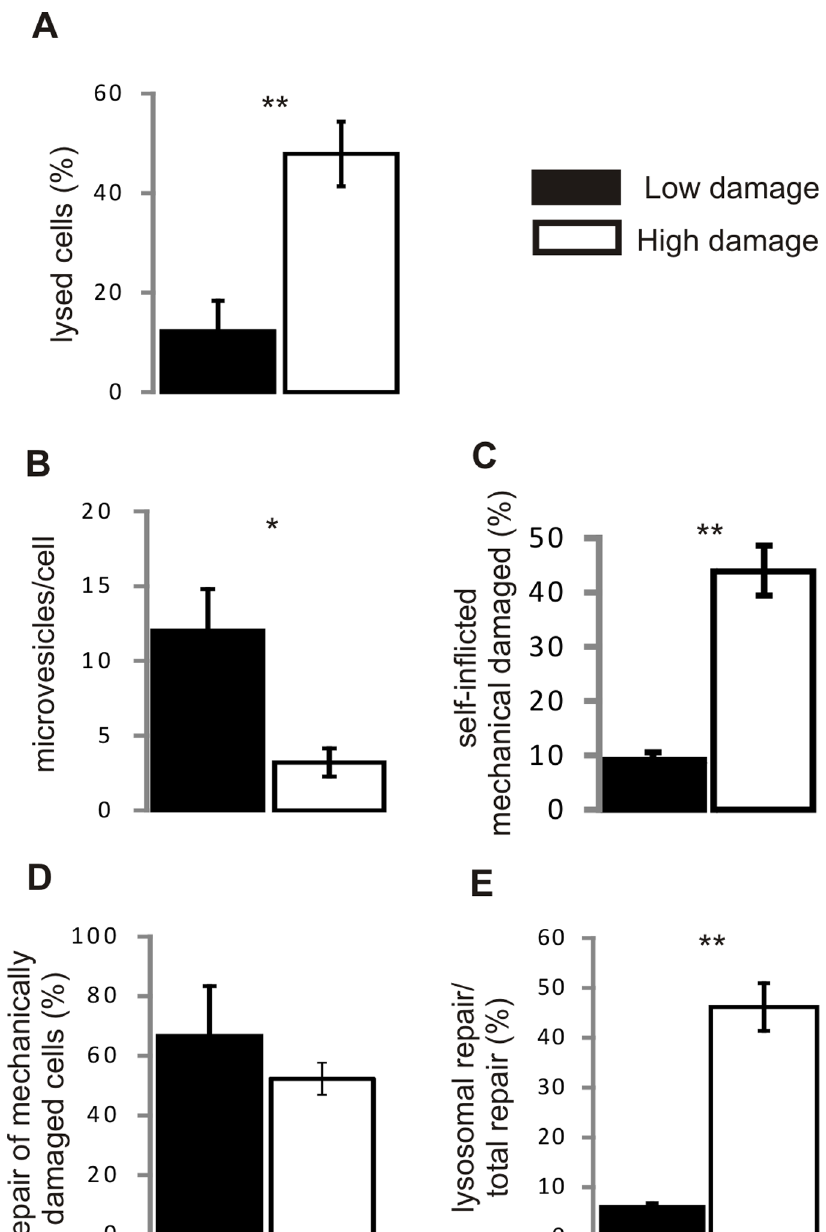
Figure 8. Microvesicle shedding is responsible for the initial elimination of toxin pores whereas lysosomal repair mends secondary, self-inflicted mechanical injuries. ( A ) Individual experiments in which SH-SY5Y cells either repaired efficiently (low damage; 72 cells, 3 independent experiments) or suffered from extensive plasmalemmal damage (high damage; 66 cells, 3 independent experiments) were analyzed for: ( B ) amount of microvesicles released per cell, ( C ) percentage of cells that suffered from secondary, self-inflicted mechanical damage (100%=total number of cells in each individual experiment), ( D ) percentage of cells that recovered after self-inflicted mechanical damage (100%=number of mechanically-damaged cells in each individual experiment), ( E ) contribution of lysosomal repair to total repair (100%=total number of repaired cells in each individual experiment). **p , 0.001, *p , 0.01.